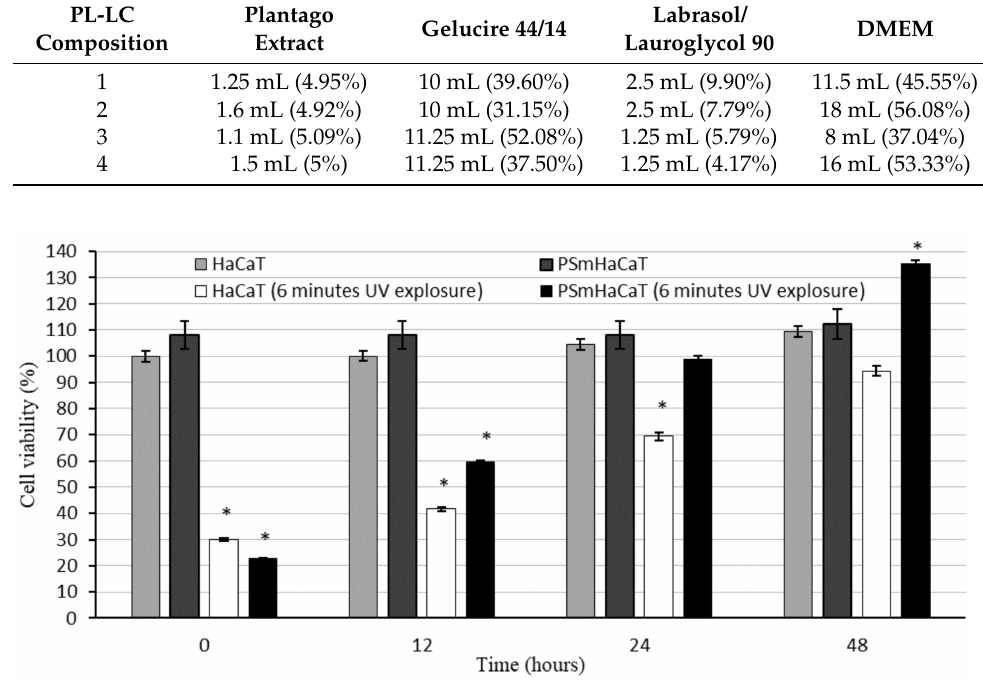
Figure 8. Cell viability evaluation with 3-(4,5-dimethylthiazol-2-yl)-2,5-diphenyltetrazolium bromide (MTT) assay on HaCaT and PSmHaCaT cells after 6 min of UV exposure and their recovery. Each data point represents the mean ± SD, n = 5. * means the data is significant since p value is 0.01 to